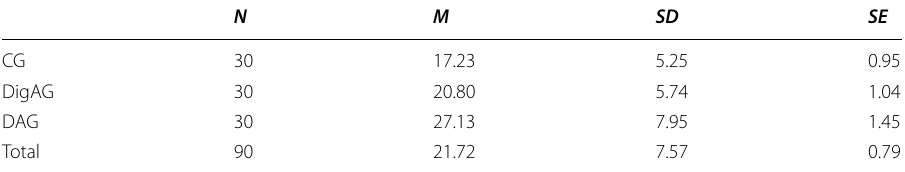
Table 12 Inferential statistics of cognitive load pretest of all groups Sum of squares df Mean square F Sig. BG 1400.98 89